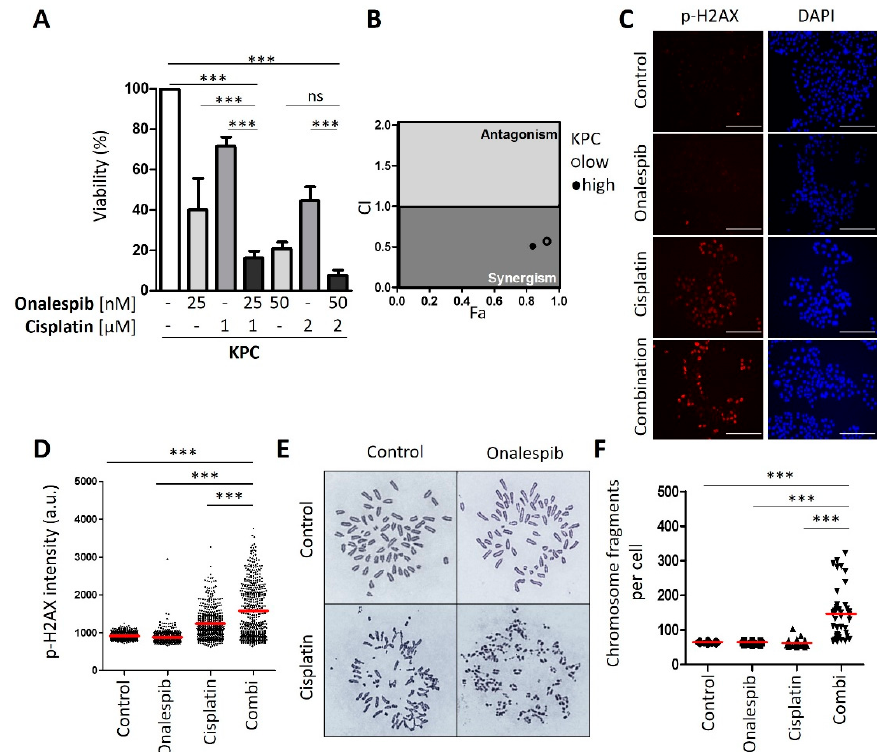
Figure 5. Synergistic effect of HSP90 inhibitors and cisplatin in KPC cells. ( A ) KPC cells (LSL- KrasG12D/+; LSL-Trp53R172H/+; Pdx-1-Cre, C57/BL6 genetic background) were treated with two different concentrations of onalespib and cisplatin for 48 h, followed by the assessment of cell viability by quantification of ATP. Mean ± SD. Note that KPC cells displayed a cisplatin sensitivity comparable to human PDAC cells that we had classified as “sensitive” but were still further sensitized by onalespib. This may well be due to intrinsic differences between human and human cells regarding their response to cisplatin. ( B ) Combination index (CI) calculated from ( A ) plotted against the fraction affected (Fa) for the combination of HSP90 inhibitors onalespib and cisplatin. ( C ) Representative images obtained by immunofluorescence staining for phospho-H2AX, with DAPI as counterstain. Cells were treated with onalespib and/or cisplatin for 24 h. Scale bar, 200 µ m. ( D ) Scatter plot of phospho-H2AX intensity per nucleus (arbitrary units), calculated by quantification of ( C ). The red lines indicate the mean nuclear phospho-H2AX staining intensity. ( E ) KPC cells were treated with onalespib (100 nM) and/or cisplatin (2 µ M) for 24 h in the presence of 20 µ M zVAD. The chromosomes were stained with Giemsa. Representative images of metaphase spreads are shown. ( F ) The chromosome fragmentation was analyzed by counting the number of fragments shown in ( F ) in 40 randomly chosen cells from three independent experiments, depicted as scatter blot. ( A , D , F ) p values were calculated with 1way ANOVA comparing the indicated groups. ns = not significant, *** p ≤